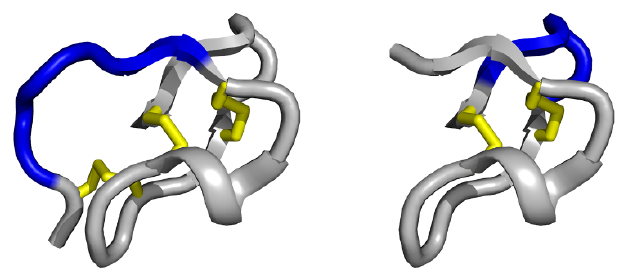
Figure 3. Schematic representation of Ecballium elaterium trypsin inhibitor II (left) and its functional miniature scaffold Min-23 (right), showing the cystine-stabilised β -sheet (CSB) motif of the knottin family (disulfide bridges are coloured in yellow). The single exposed variable loop (coloured in blue) is permissive to the variation of six amino acids in EETI-II and 8 to 10 in Min-23, respectively. Structural representations (PDB ID: 2IT7) were illustrated using PyMol software